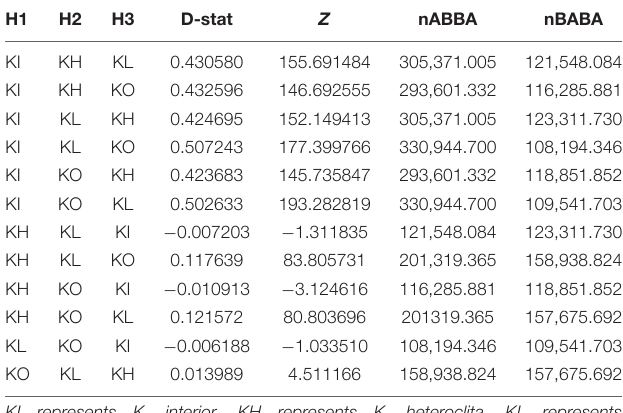
TABLE 4 | D-statistics for gene flow involving four species.